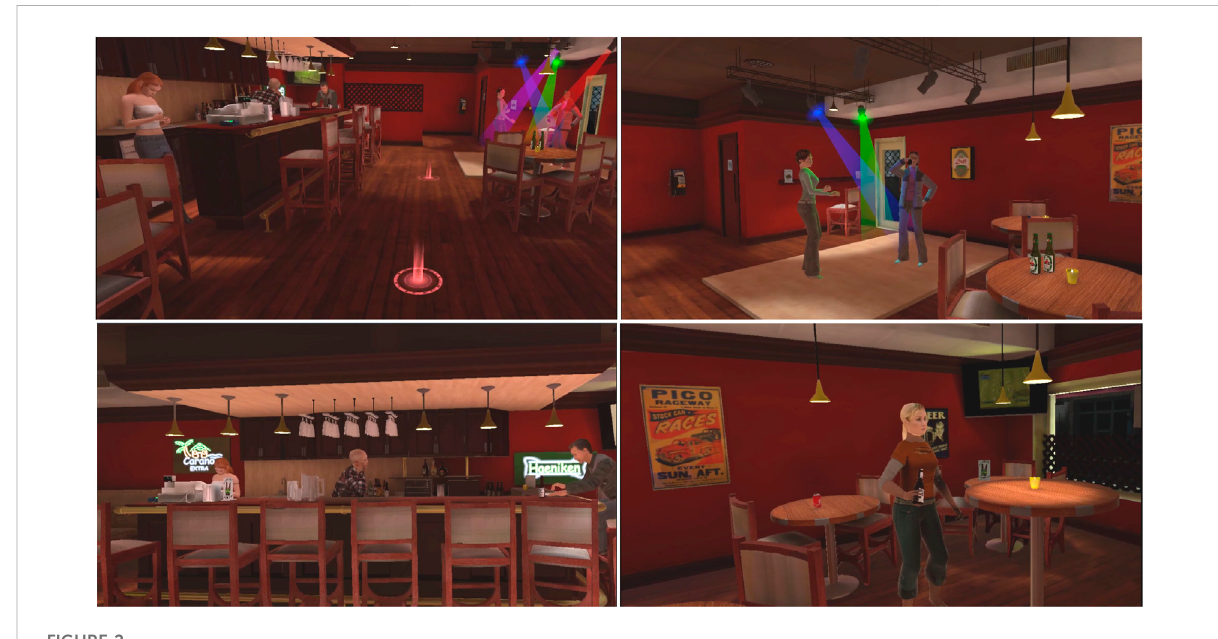
FIGURE 2 Screenshot of the virtual environment and light markers on the ground.